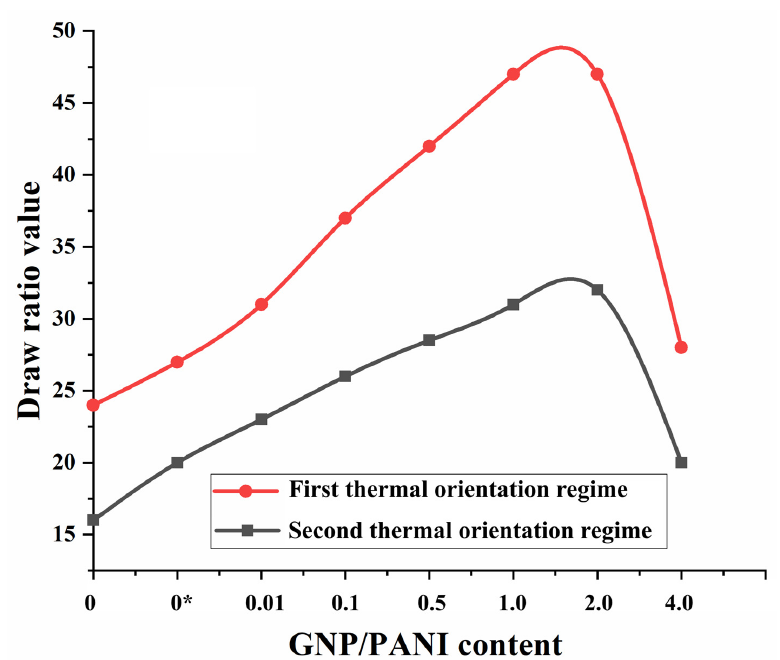
Figure 5. The effect of the addition of GNP/PANI on the values of the draw ratio of the UHMWPE films. (0*)—UHMWPE/1.0 wt. % PE-wax without GNP/PANI.